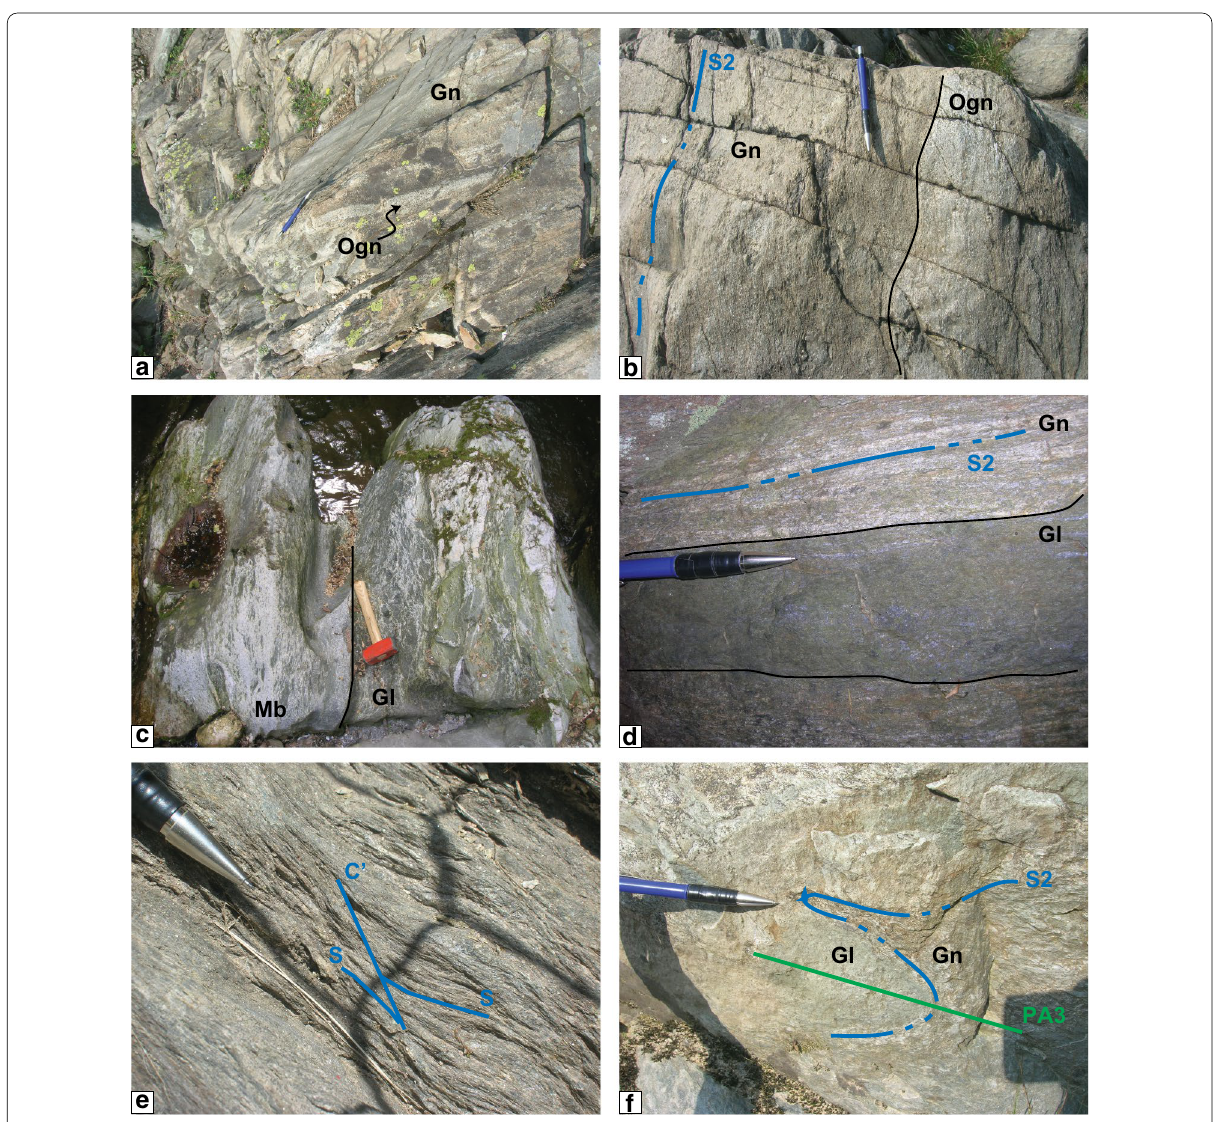
Fig. 2 Mesostructures and dominant fabrics of rock types constituting the MZ and the RCTU. a Gneiss (Gn) enclosing a small dyke of orthogneiss (Ogn). x 1387620, y 5018403. b Boundary between gneiss (Gn) and orthogneiss (Ogn) sub-parallel to the S2 mylonitic foliation. x = = y 5018380. c Contact between silicates-bearing marble (Mb) and glaucophanites (Gl). x = (Gn) and glaucophanites (Gl) parallel to the S2 mylonitic foliation. x glaucophanites indicating top-to-the right shear sense (dextral). x the contact between gneiss (Gn) and glaucophanites (Gn). x